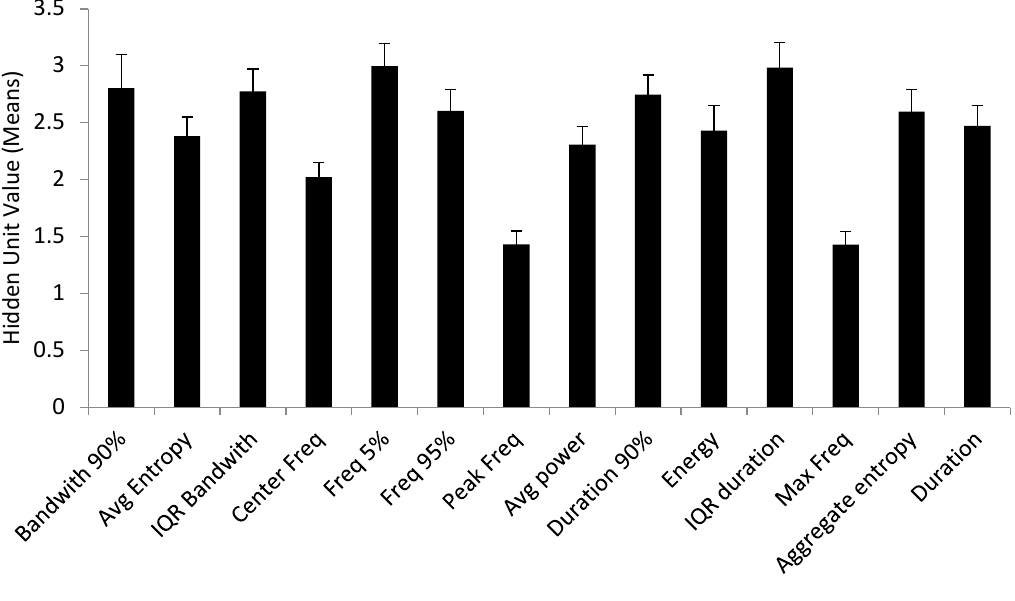
Figure 6 . Mean hidden unit values calculated for each acoustic parameter for neural networks trained to sort whistles into four age classes. Values were calculated from all networks and all hidden units to indicate overall acoustic parameter significance. Bars are standard errors of the